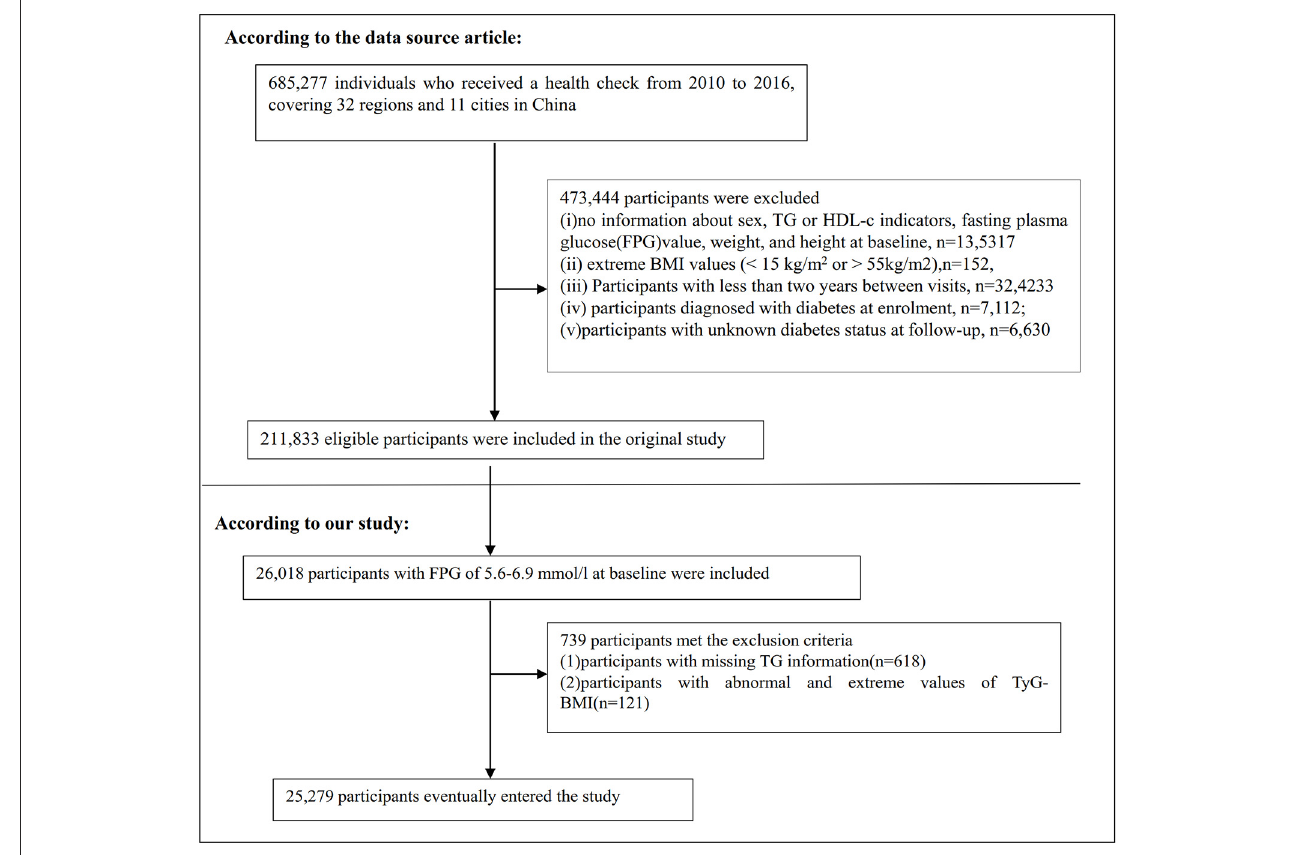
FIGURE1 Flowchart of study